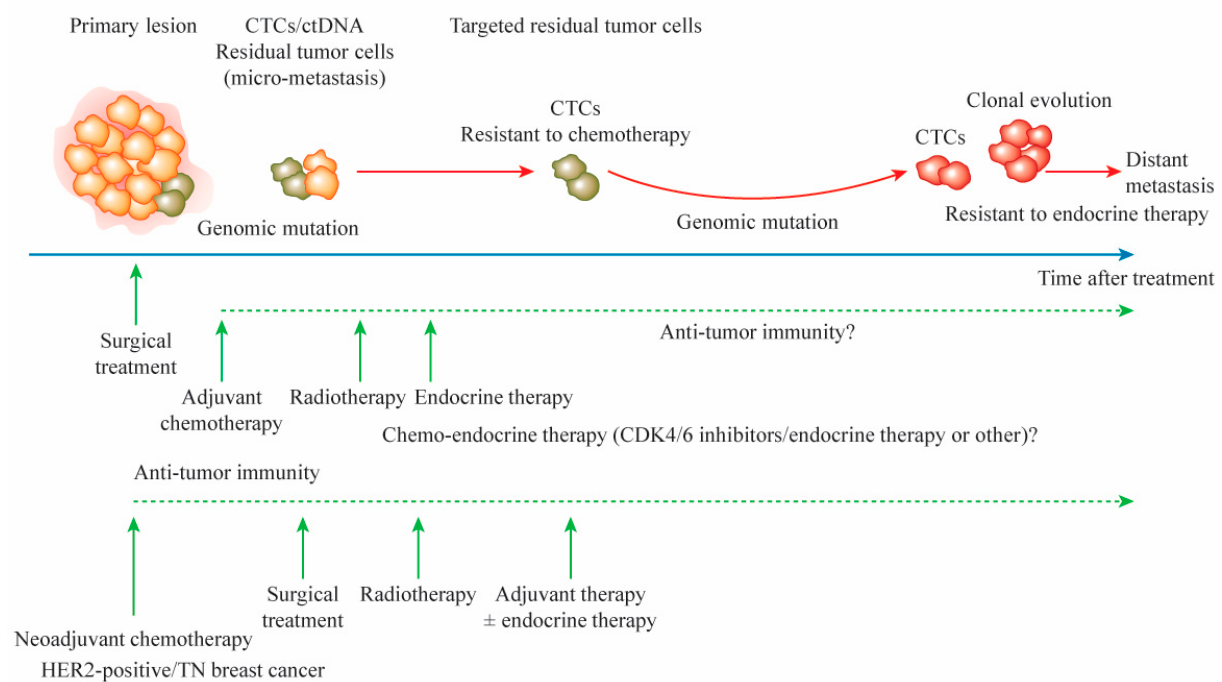
Figure 1. A time course for distant metastasis after adjuvant and neoadjuvant therapies in patients with breast cancer. Although primary lesions and axillary lymph nodes can be removed maximally by surgical treatment, the minimal presence of residual tumor cells, as assessed by CTC and ctDNA analyses, contributes to recurrence and distant metastasis. Genomic mutations in primary tumors can cause resistance to anticancer agents and endocrine therapy. The remaining tumor cells with genomic mutations cause the clonal evolution of tumor growth, leading to distant metastasis. The use of adjuvant therapy in combination with endocrine therapy and CDK4/6 inhibitors may improve survival. After neoadjuvant chemotherapy, additional adjuvant chemotherapy targeting residual tumor cells improves survival. CTC, circulating tumor cell; ctDNA, circulating tumor DNA; CDK, cyclin-dependent kinase; HER-2, human epidermal growth factor receptor 2; TN, triple negative.